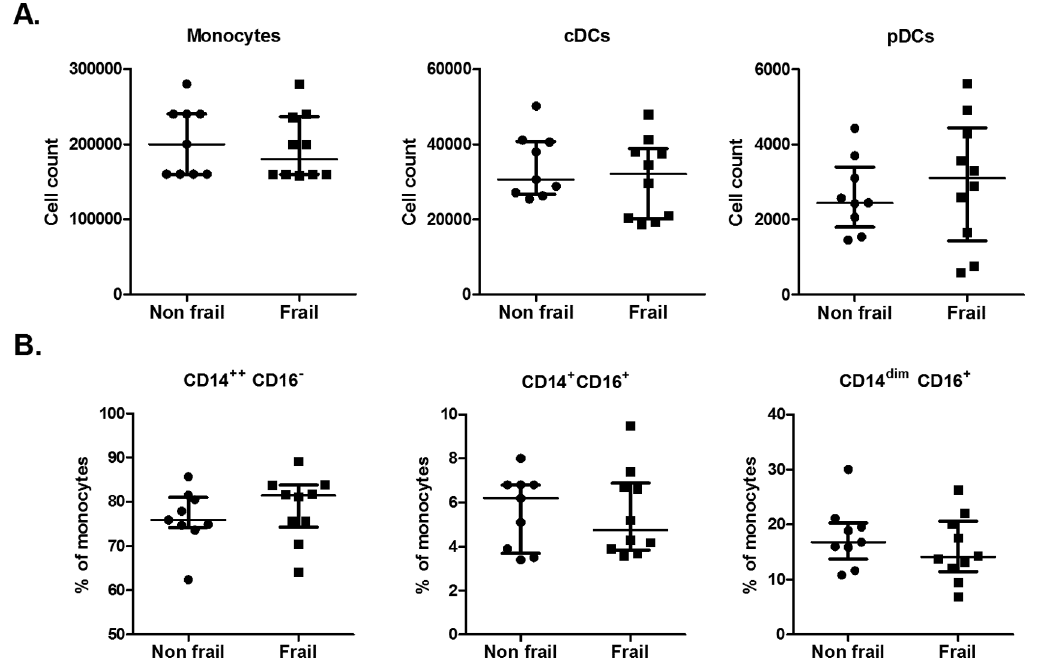
Figure 3. Monocytes and DC subsets in a subgroup of non frail and frail old subjects. Whole blood cells were immediately fixed and stored in FACS cells lysing buffer after blood collection. A) Absolute cell counts of monocytes (Lineage 2 HLA-DR + CD11c + CD14 + ), cDCs (Lineage 2 HLA- DR + CD11c + CD14 2 CD123 2 ) and pDCs (Lineage 2 HLA-DR + CD11c 2 CD14 2 CD123 + ). B) Relative proportion of monocyte subsets: CD14 ++ CD16 2 , CD14 + CD16 + and CD14 dim CD16 + . Each dot represents a single donor and the bars represent median values 6 interquartile